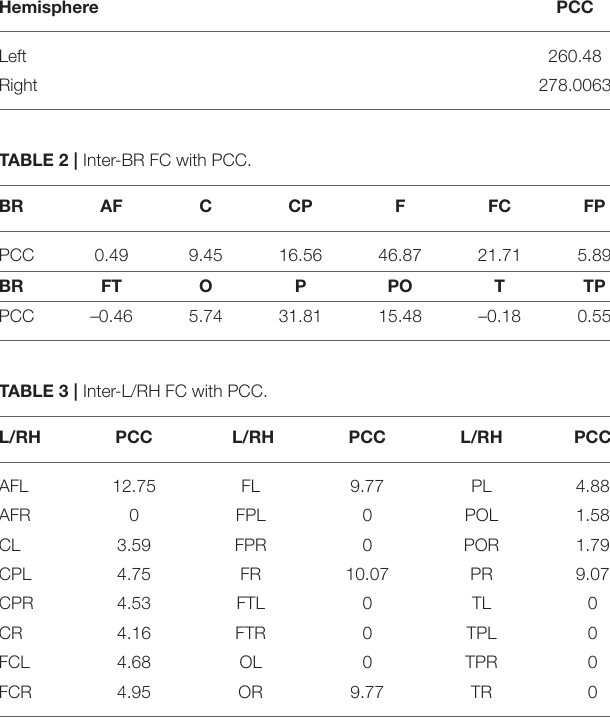
Figure 8A is the connectivity of PCC of the left and right brain hemispheres. Figures 8B,C show between-L/RH connectivity of 1/2 and 1/8 of